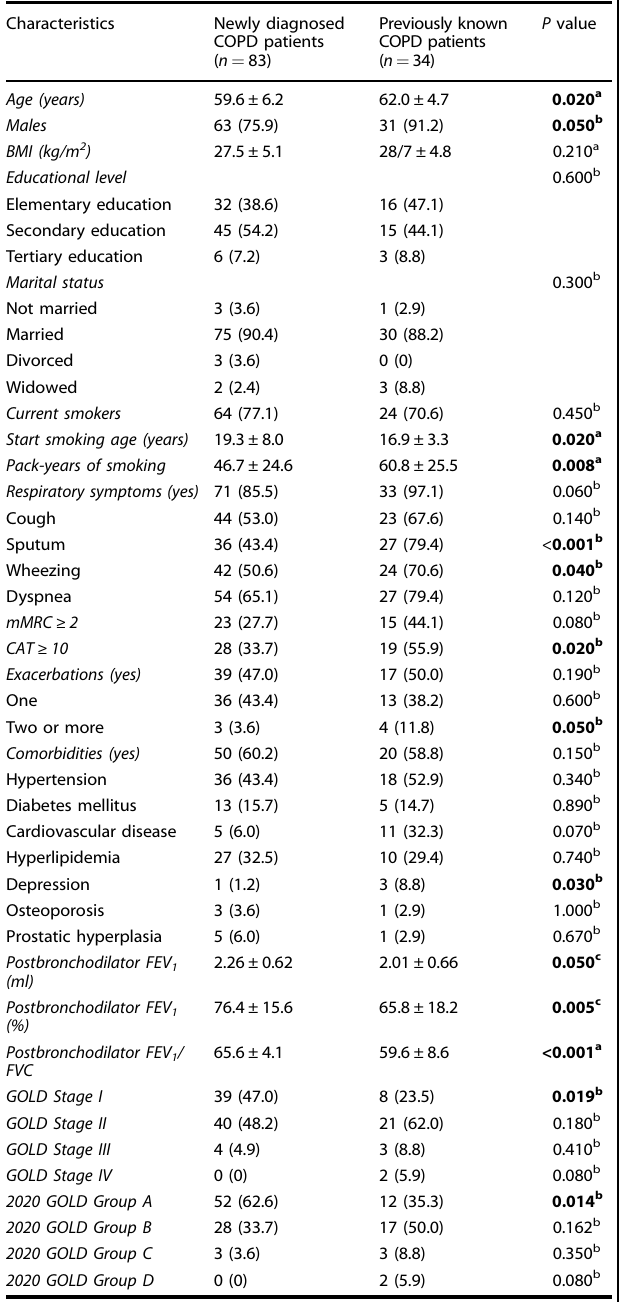
Table 3. Comparisons of demographic, clinical, and spirometric characteristics of newly vs. previously diagnosed COPD